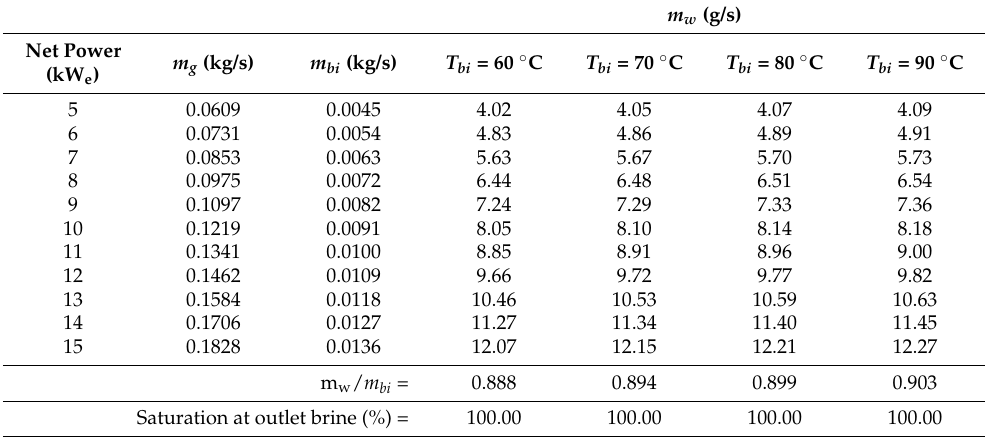
Table 10. Water evaporated for SMGT; Pressure Ratio = 4.5, T gi = 285.09 ◦ C, S bi = 0.07 kg/kg, S sat = 0.296 kg/kg, m g / m bi = 13.45.